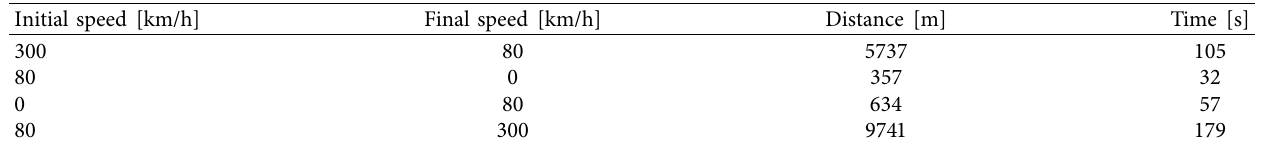
Table 5: Computation results at different initial and final speeds.